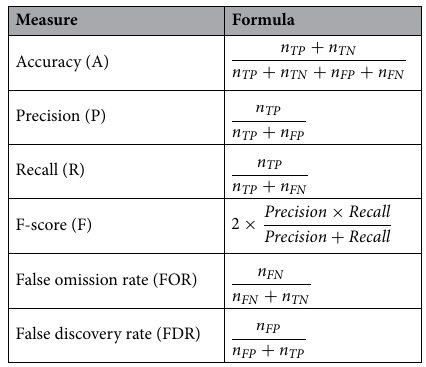
Table 2. Formulas for the statistical features extracted from the confusion matrix, where n TP , n FP , n TN and n FN represent the number of true positives, false positives, true negatives and false negatives,